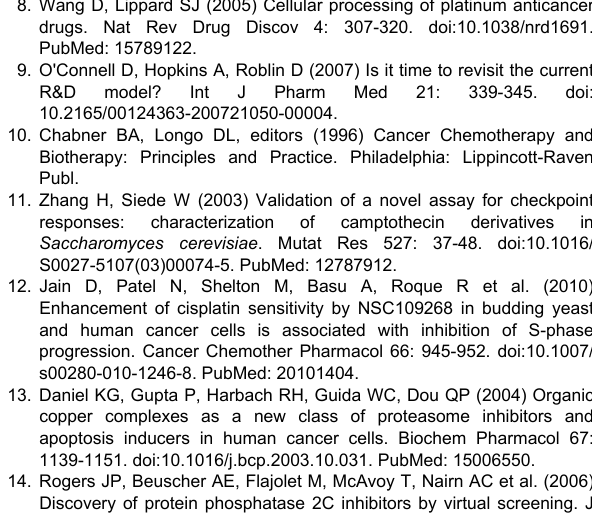
Table S1. Mutants studied for influence of NSC109268 on cisplatin sensitivity, ranked by dose enhancement factor (DEF) at 50% survival. See also Figure